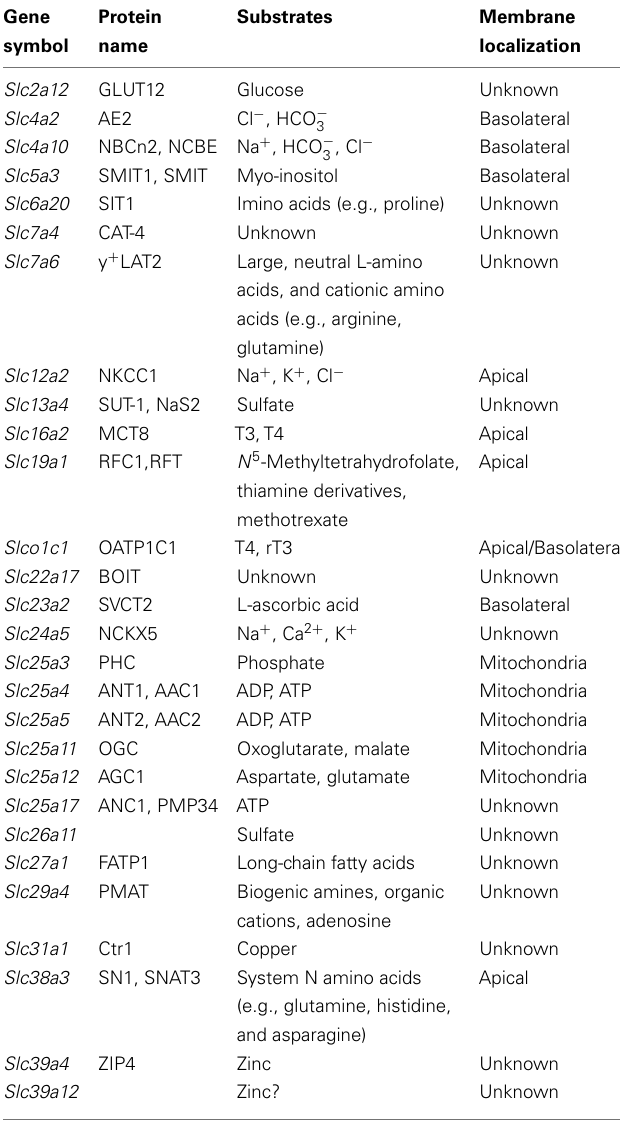
Table 1 | Slc genes with highest expression in the mouse choroid plexus (CP; Dahlin et al.,